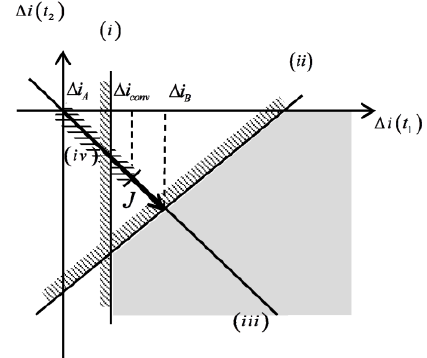
Figure 8. Domain and optimal solution for the hysteresis current band.